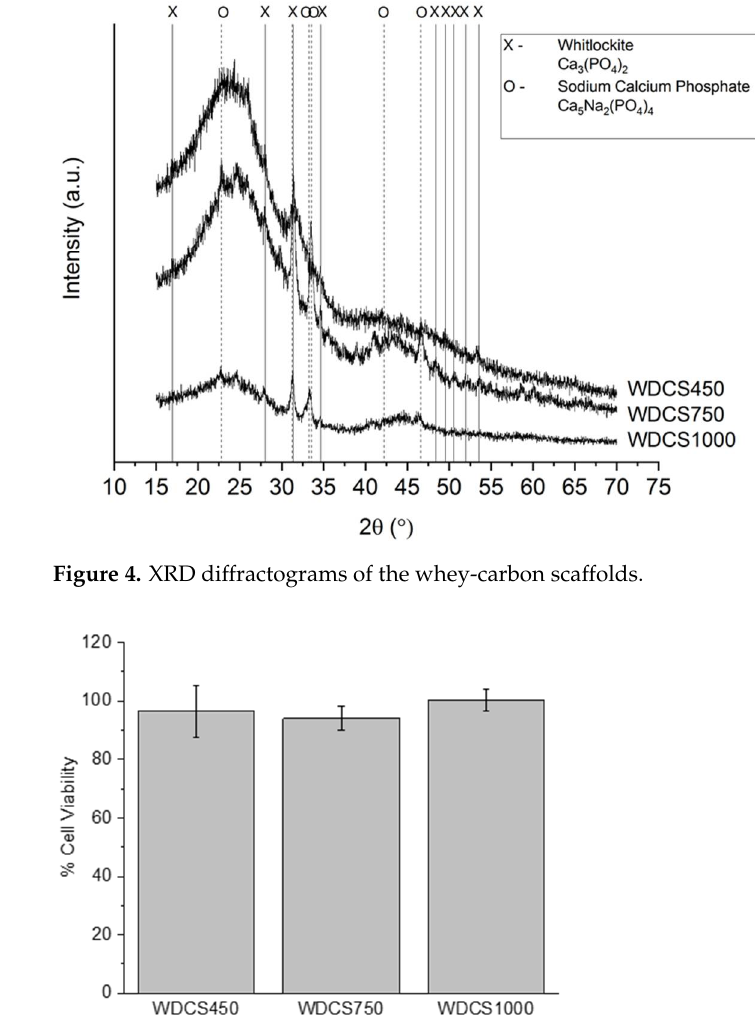
Figure 5. Cell viability percentage of SaOs-2 cells after incubation during 24 h with extracts of WDCS450, WDCS750 and WDCS1000.